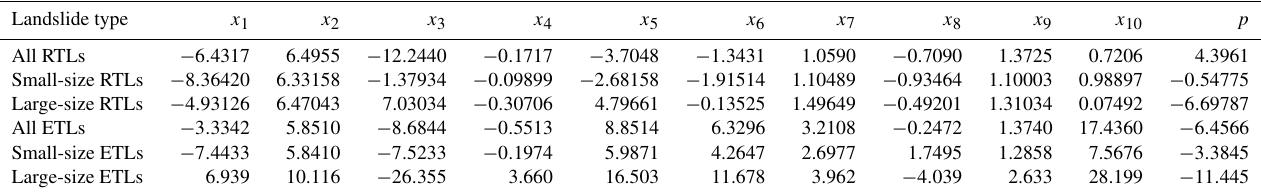
Figure 6. Correlation between landslides and other factors for rainfall-triggered landslides (RTLs; a , c ) and earthquake-triggered landslides (ETLs; b , d ). The size of the circles indicates the value of the frequency ratio. (a, b) Relation between altitude and slope gradient. (c, d) Relation between lithology and slope gradient. Table 2. Susceptibility models for different triggers and landslide size classes in the Koshi River